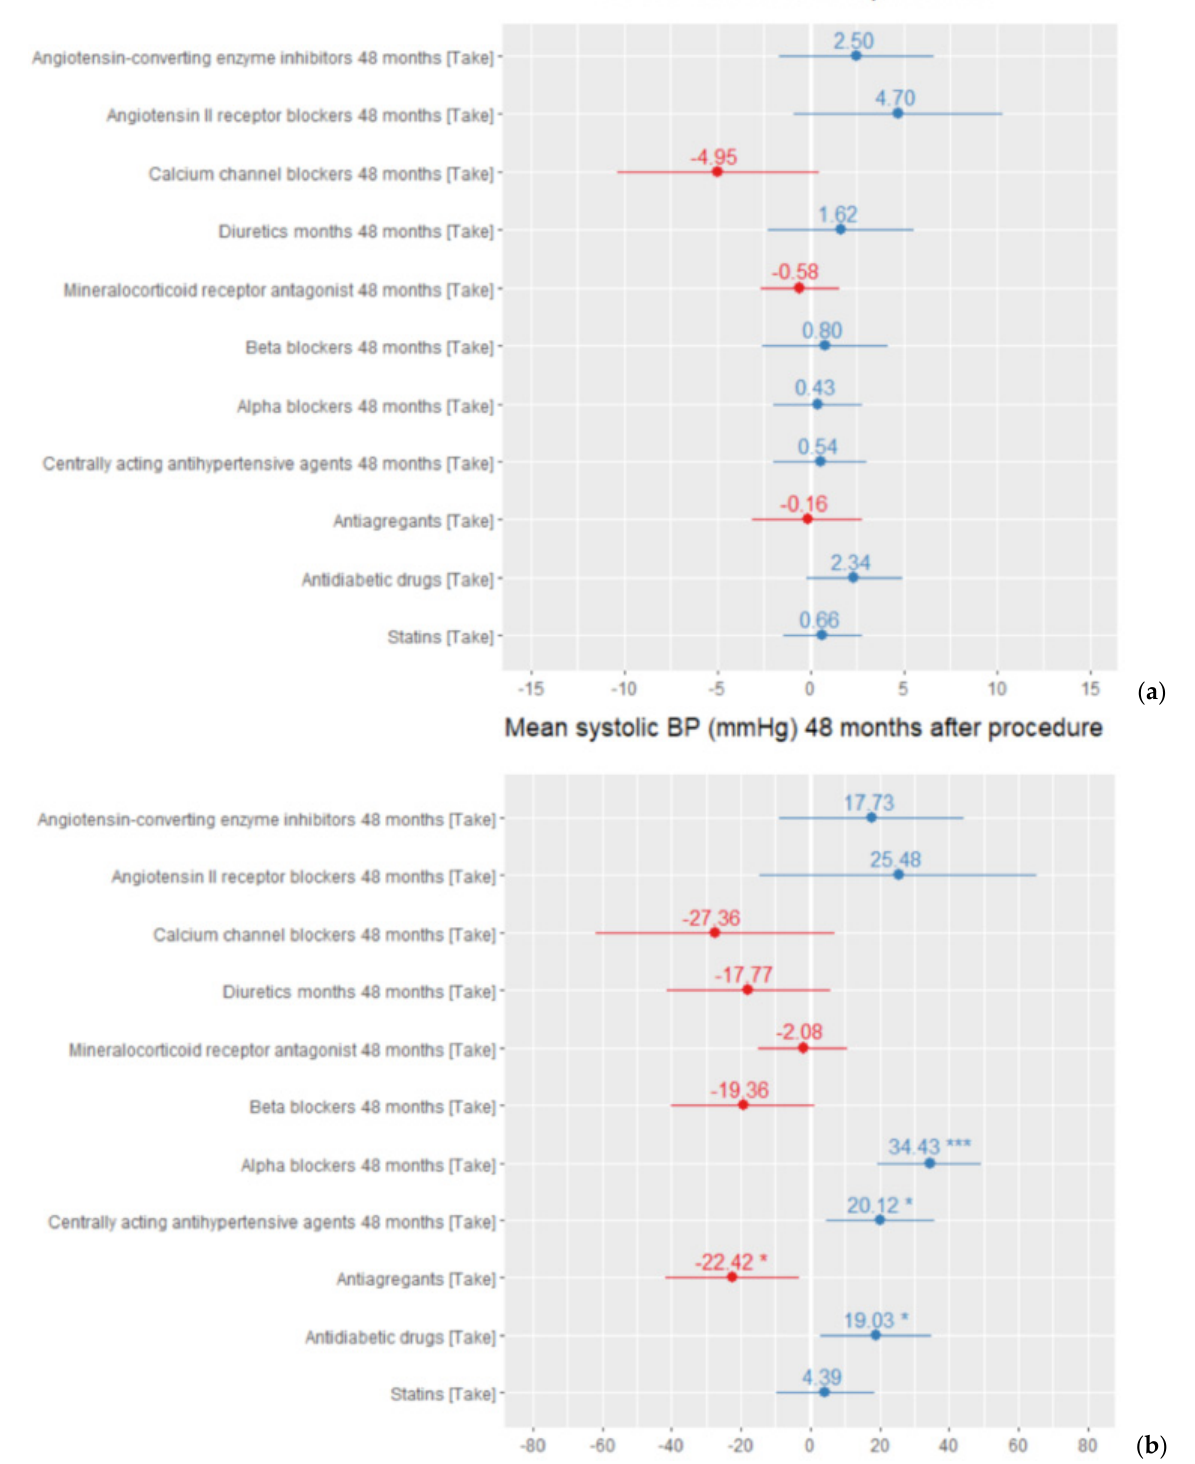
Figure 4. Mean regression model for drug treatment influence on ( a ) arterial stiffness (CfpWV in m/s) after 48 months ( R 2 = 0.66, adjusted R 2 = 0.44, p = 0.01). ( b ) Office systolic blood pressure (in mmHg) after 48 months ( R 2 = 0.66, adjusted R 2 = 0.44, p = 0.01). * p < 0.05, ** p < 0.01, *** p < 0.001.